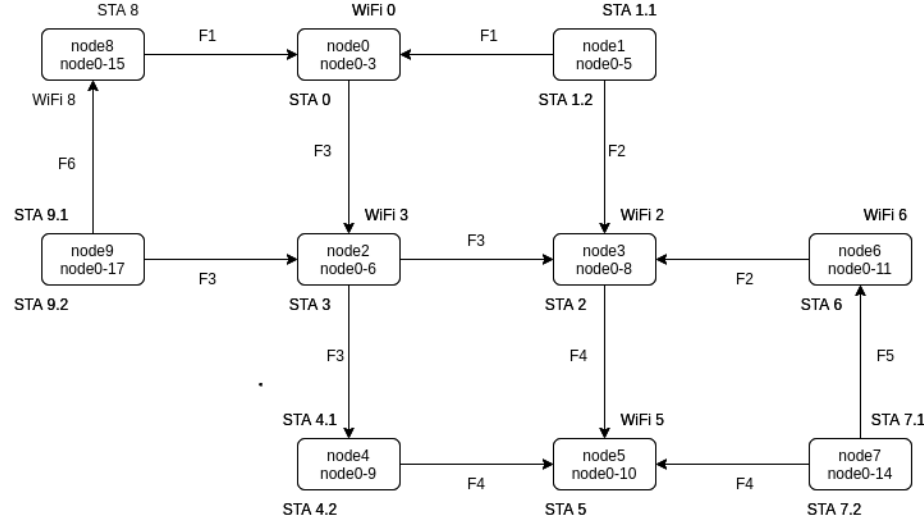
Figure 9. W-iLab1.t grid topology node setup.